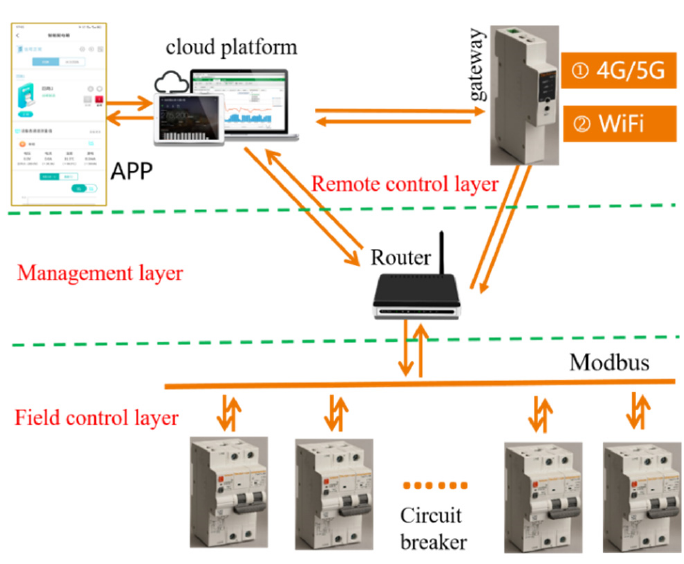
Figure 5. Intelligent overall architecture of circuit breaker.